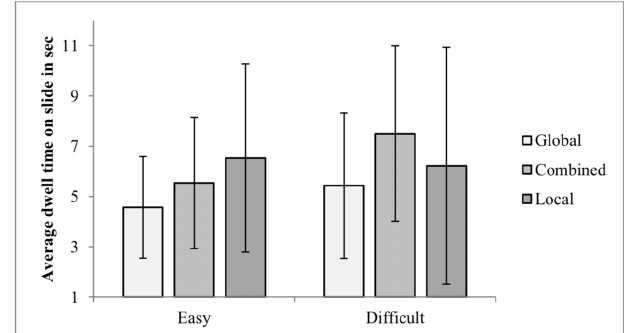
Figure 5. Average Dwell Time on Slide on the CWMR Test.